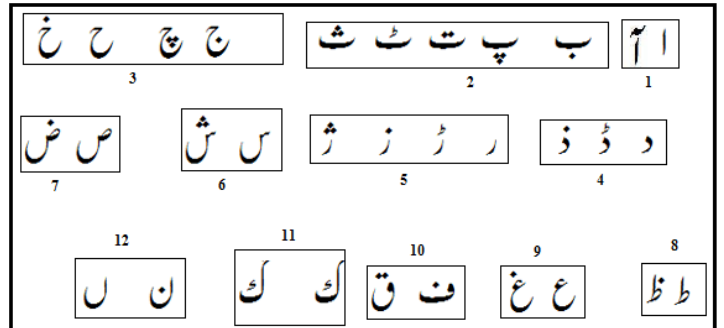
Figure 10. Grouping of Urdu characters according to shape similarity. Each groups is numbered from right to